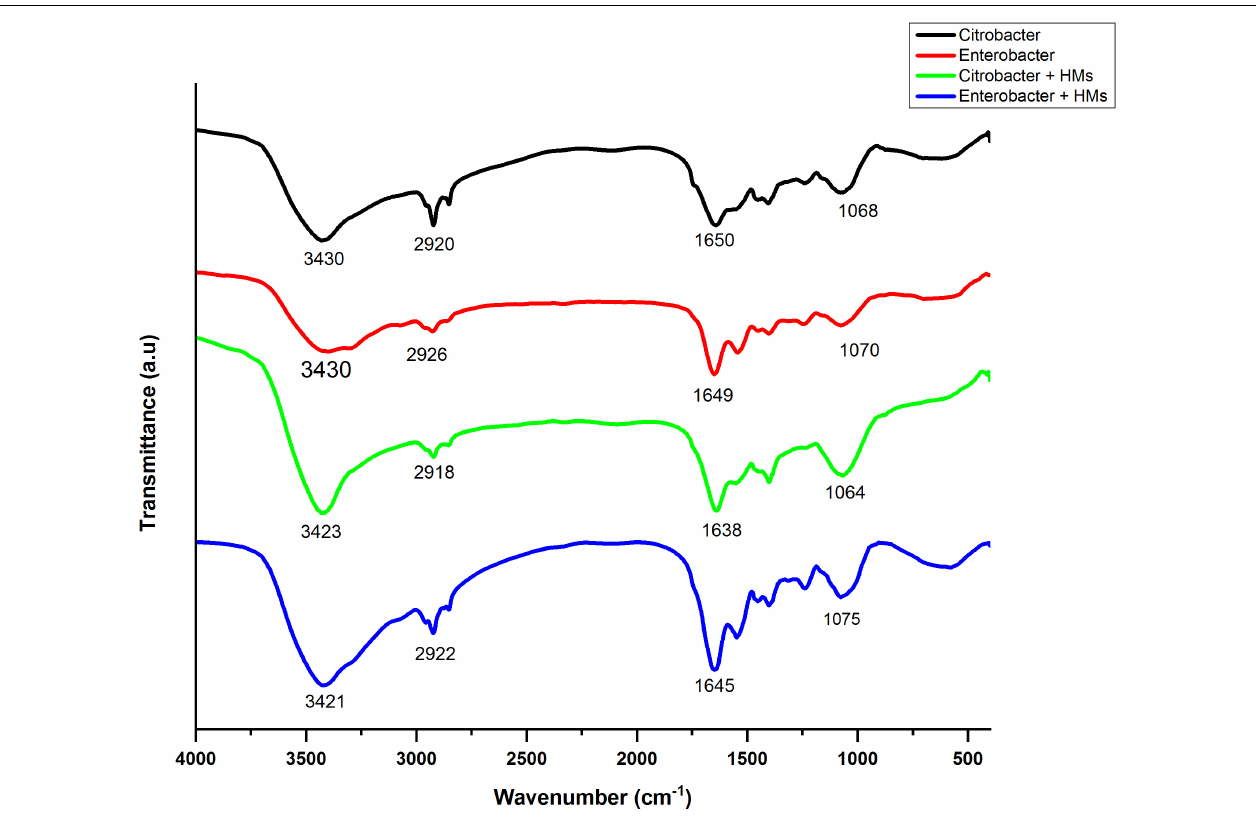
FIGURE 8 | Infrared spectra of Citrobacter werkmanii strain WWN1 and Enterobacter cloacae strain JWM6 biomass in the presence of heavy metals (HMs) (Ni, Cd,